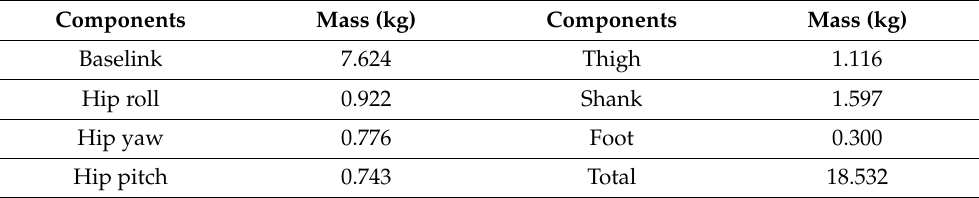
Table 2. Mass Distribution.